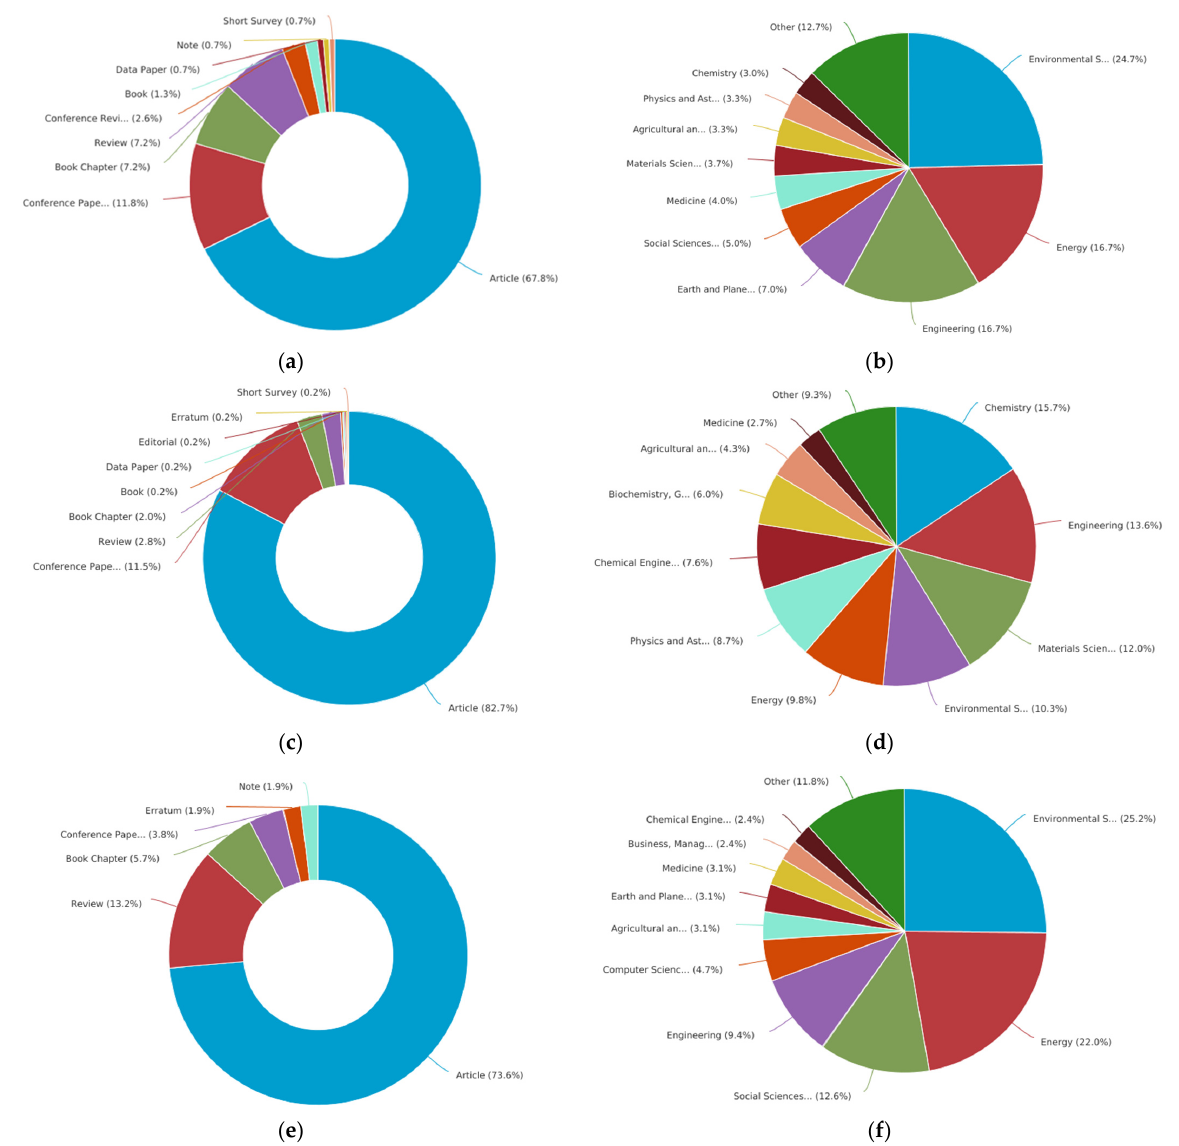
Figure 2. Distribution of research production by document type and subject area, according to Scopus database, for specific keyword strings (search cases C1, C2 and C3 from Table 1): ( a , c , e ) document type; ( b , d , f ) subject area.